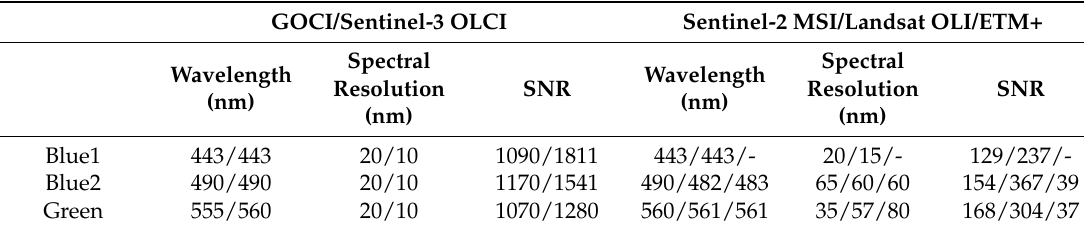
Table 2. Comparison of wavelength, spectral resolution, and SNR among sensors.